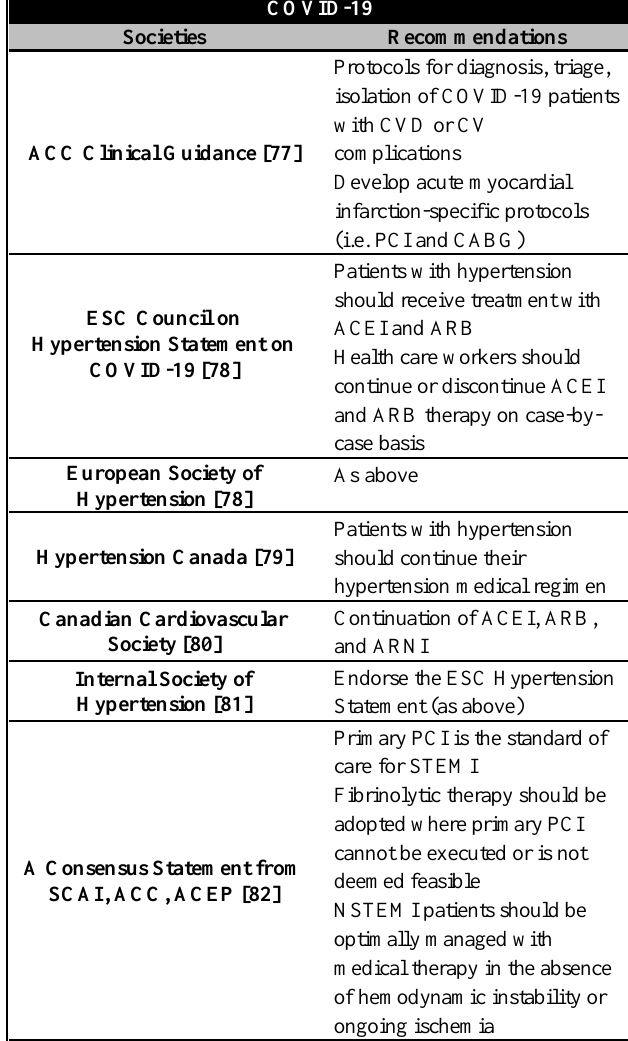
Table 3. Guideline considerations with regard to CVD and